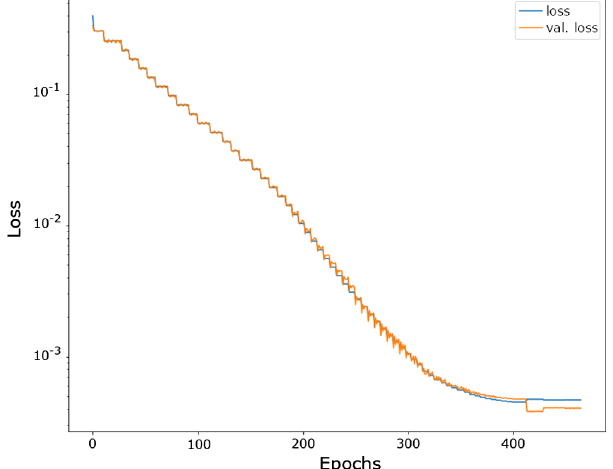
FIG. 5. Loss function as a function of the number of training epochs for the Booster LSTM surrogate model. The blue line gives the loss values for training sample and the orange line is the calculated loss using validation samples.